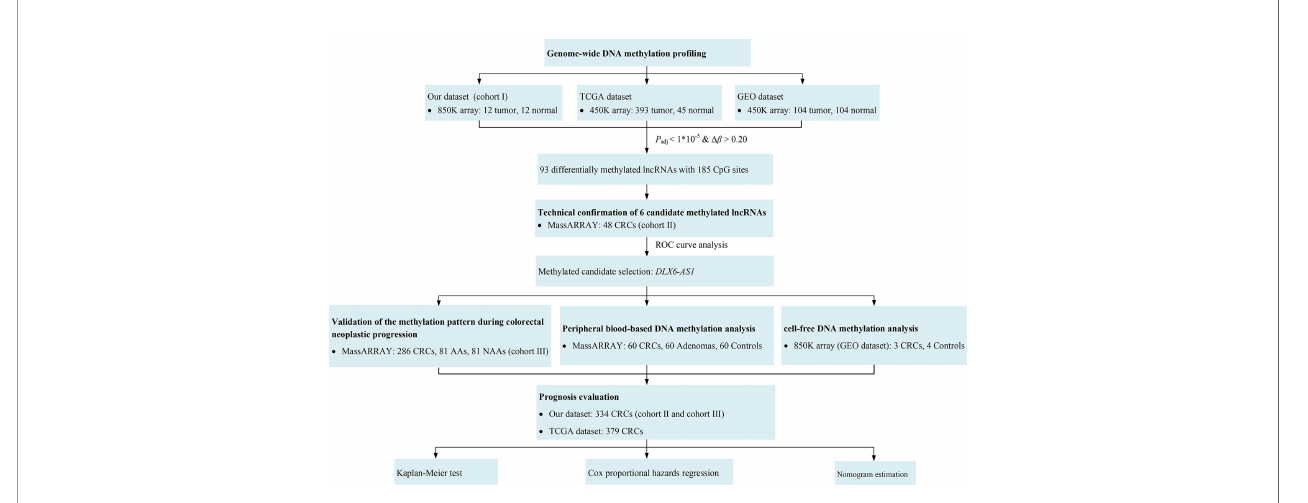
FIGURE 1 | Study fl owchart. AA, advanced adenoma; CRC, colorectal cancer; NAA, nonadvanced